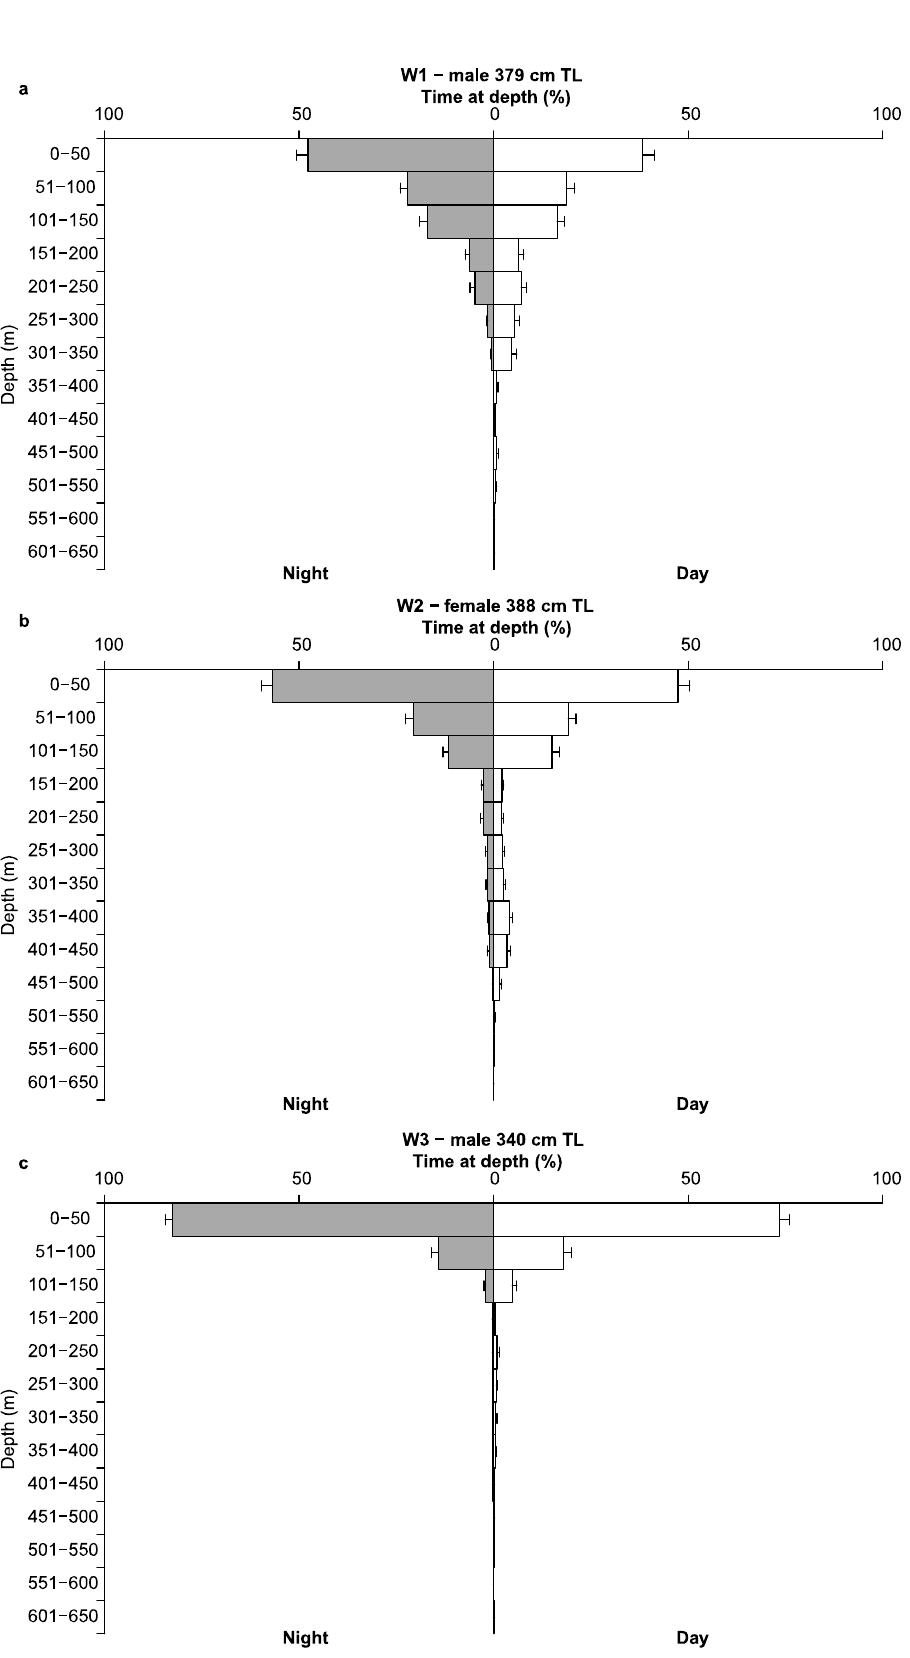
Figure 4. Time spent (%±SE) at depth (m) during the day (white bars) and at night (grey bars) for three white sharks ( C. carcharias ) ( a ) W1, ( b ) W2 and ( c ) W3.